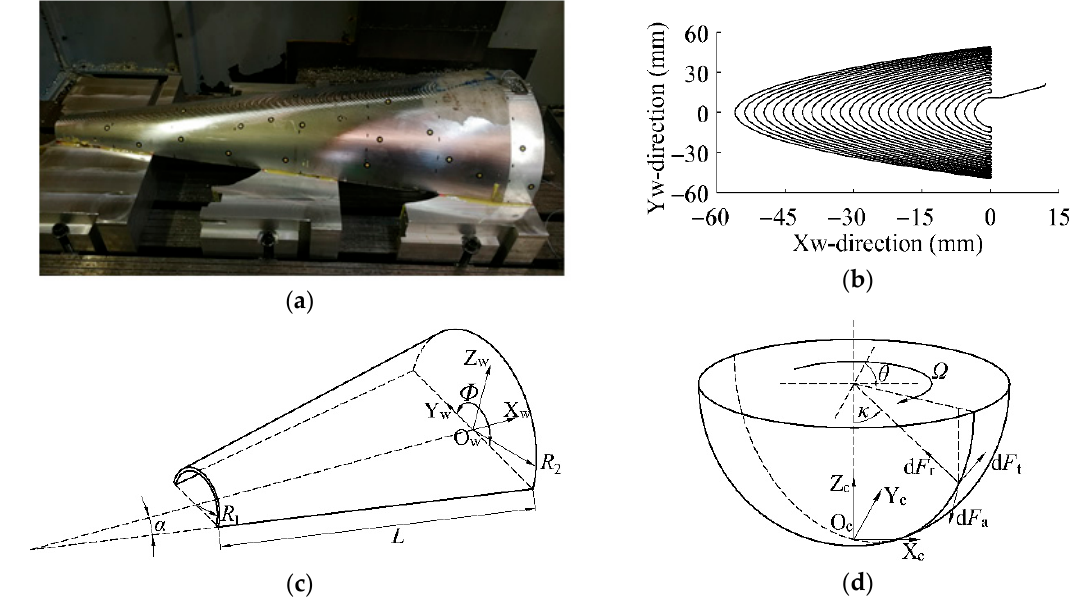
Figure 2. ( a ) Experimental setup of the semi-conical shell workpiece; ( b ) partial schematic of the contour line tool path; ( c ) schematic diagram of the workpiece and coordinate system O w -X w Y w Z w ; ( d ) schematic diagram of the ball-endmill cutter and coordinate system O c -X c Y c Z c